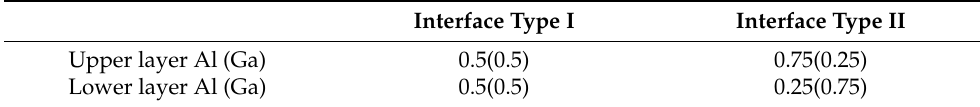
Figure 9. The [100] ( a ) and [001] ( b , c ) views of the supercell of a Ga(Al)N layer of the (GaN) 4 /(AlN) 4 SL. Right panel: a view of the upper interface layer ( b ), a view of the lower interface layer ( c ). Blue, cyan, and brown balls are N, Ga, and Al atoms, respectively. Table 1. Two cases of partial occupancy values of cation atomic positions in interface layers of the parent high-symmetry